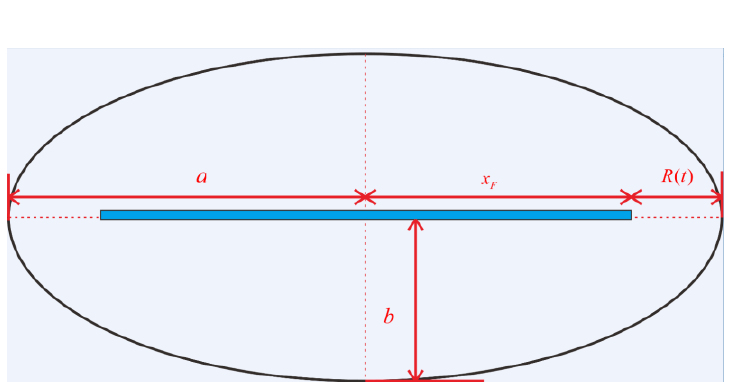
Figure 4. Schematic of the elliptical seepage area.